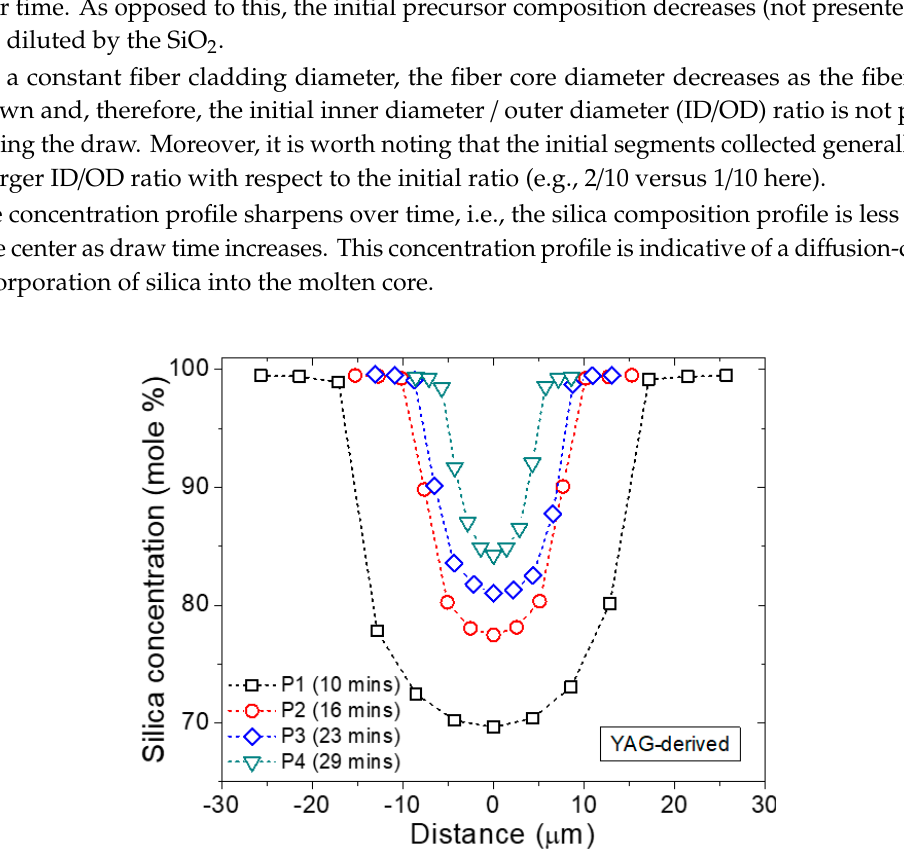
Figure 1. Electron Dispersive X-ray (EDX) elemental analysis of the silica concentration (in mol %) as a function of core radial position for a YAG-derived optical fiber fabricated using the Molten Core Method (MCM), and for various fiber segments collected at different times during fiber drawing. Table 1. Fiber segments collected during the draw and their respective properties (composition is in mol %). Segment